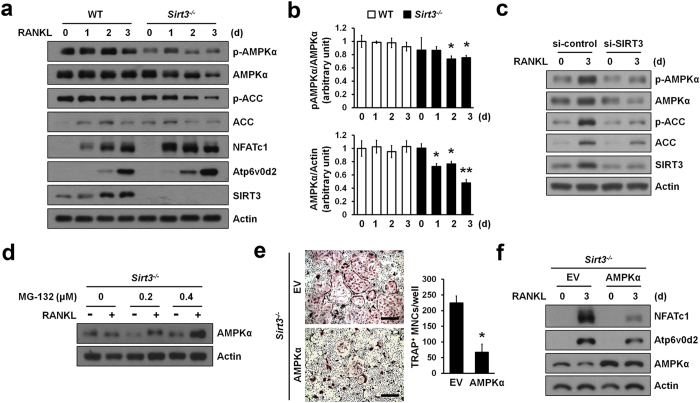
SIRT3 regulated AMPK stability.(a) BMMs from WT or Sirt3−/− mice were stimulated with RANKL for the indicated time periods. Activation of AMPK or ACC and expression levels of NFATc1, Atp6v0d2, and SIRT3 during osteoclast differentiation. (b) The chemiluminescence signals for phospho-AMPK and AMPK were quantified and normalized based on the signals of AMPK and actin, respectively. Data represent means ± SD *P < 0.05, **P < 0.01. (c) RANKL stimulated BMMs transfected with si-control (scramble siRNA) or si-SIRT3 (siRNA against SIRT3) were immunoblotted with the indicated antibodies. (d) AMPK degradation in Sirt3−/− osteoclasts is inhibited by proteasome inhibitor. BMMs from Sirt3−/− mice were stimulated with RANKL in the absence or presence of MG-132 for 3 days. AMPK protein level was determined. Actin serves as a loading control. (e) Retroviral AMPKα introduction rescued osteoclast differentiation in Sirt3−/− BMMs. Sirt3−/− BMMs were transduced with empty or AMPKα retrovirus and then stimulated with RANKL. TRAP+MNCs (>5 nuclei) were counted. Scale bar, 500 μm. *P < 0.01. Data are represented as mean ± SD. (f) BMMs from Sirt3−/− mice were transduced with retroviruses expressing AMPKα or EV and were treated with RANKL for 3 days. NFATc1 and Atp6v0d2 protein expression was determined by immunoblot analysis. Actin serves as a loading control.